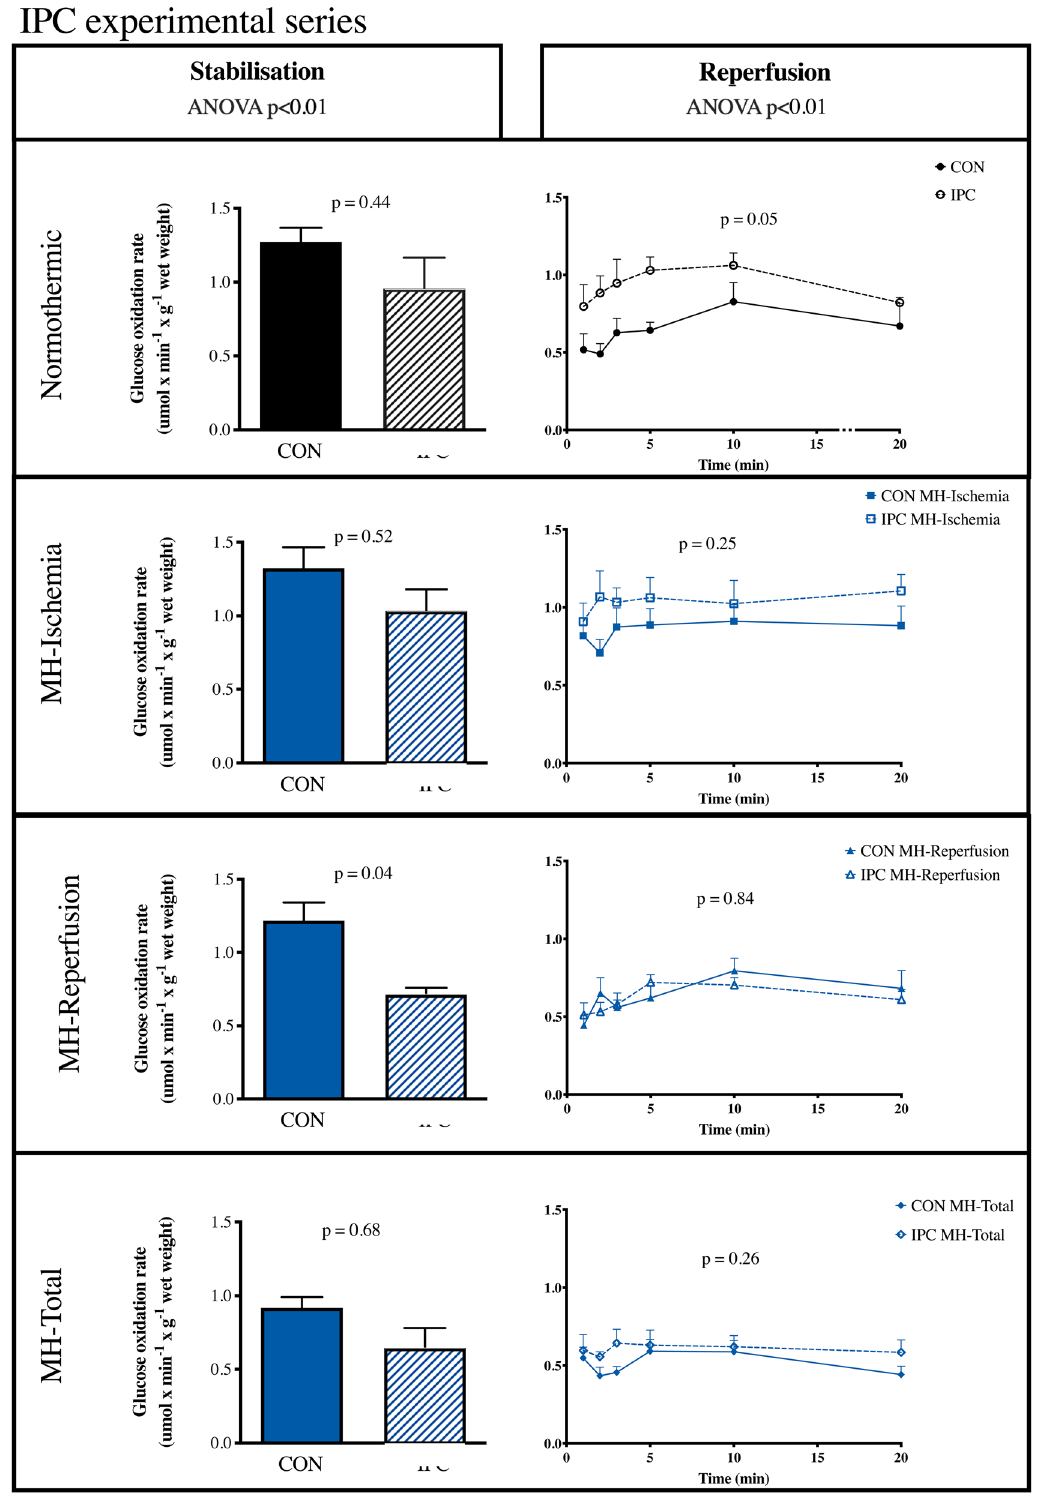
Figure 5. Glucose oxidation. CON control, IPC ischemic preconditioning, MH-Ischemia mild hypothermia during ischemia, MH-Reperfusion mild hypothermia during reperfusion, MH-Total mild hypothermia through the total